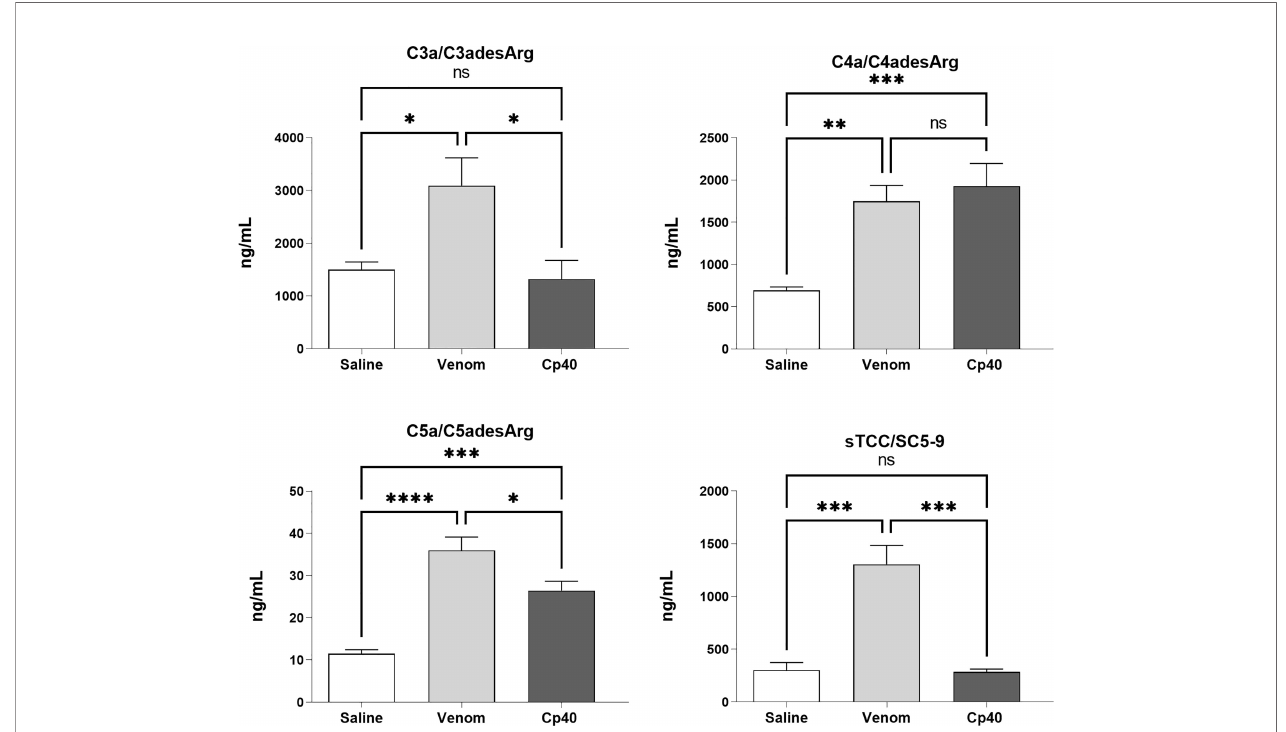
FIGURE 6 | Production of anaphylatoxins in human blood stimulated with B. jararaca venom in the presence of Cp40. Human blood samples containing GPRP (8 mg/mL) were preincubated with cp40 inhibitor (20 m M) and then incubated with B. jararaca venom (50.0 m g/mL) or sterile saline solution for 60 minutes at 37° C. After plasma collection and dilution, the production of anaphylatoxins C3a/C3a-desArg (1:5000), C4a/C4a-desArg (1:5000) and C5a/C5a-desArg (1:1000) was evaluated by cytometric bead array (CBA). The results are presented as the mean ± SEM from three independent experiments. ns, not signi fi cant; * p ≤ 0.05, ** p ≤ 0.005, *** p ≤ 0.0005, **** p <